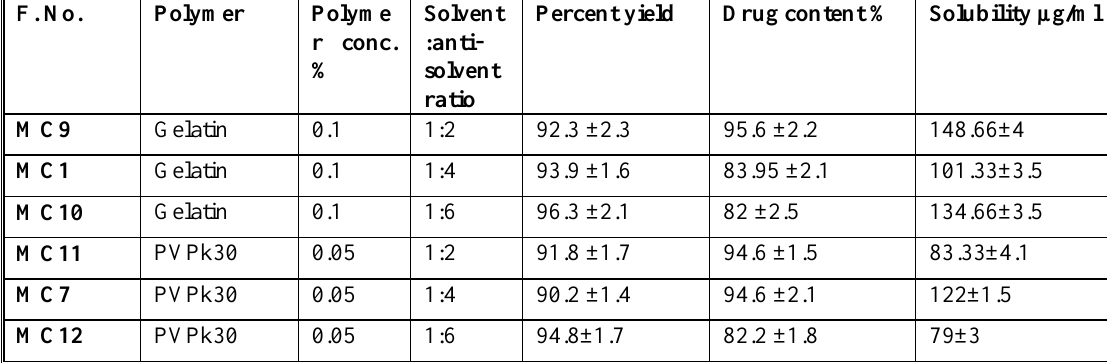
Table (4) Effect of solvent: anti-solvent ratio on SM microcrystals formulas. F.